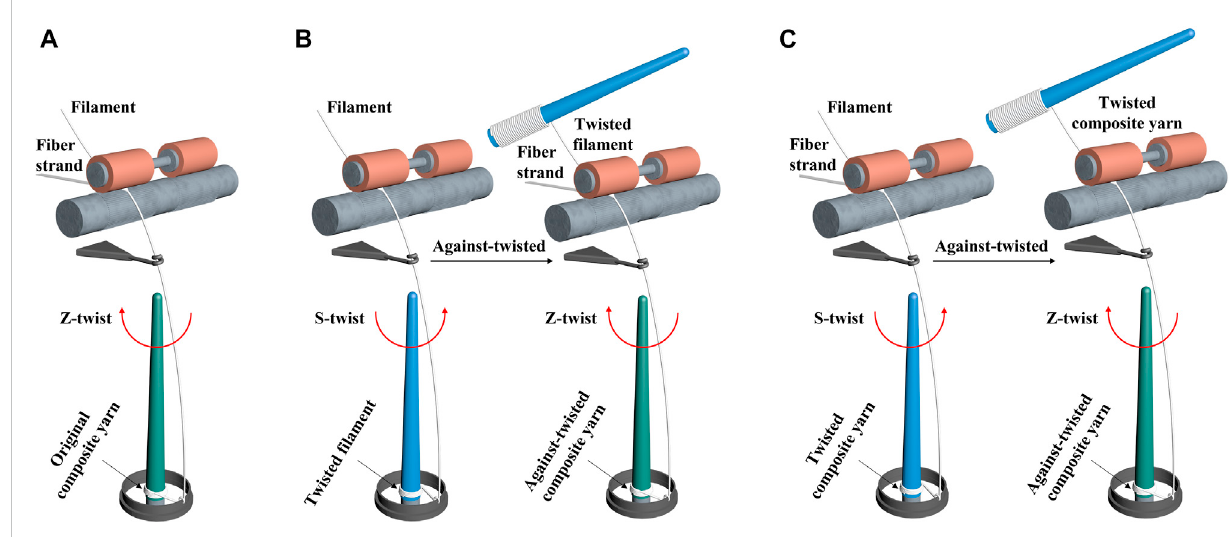
FIGURE 4 Pictorial illustration of production process on yarns for experiment: (A) A f ; (B) A g and A h and (C) A j and A k .